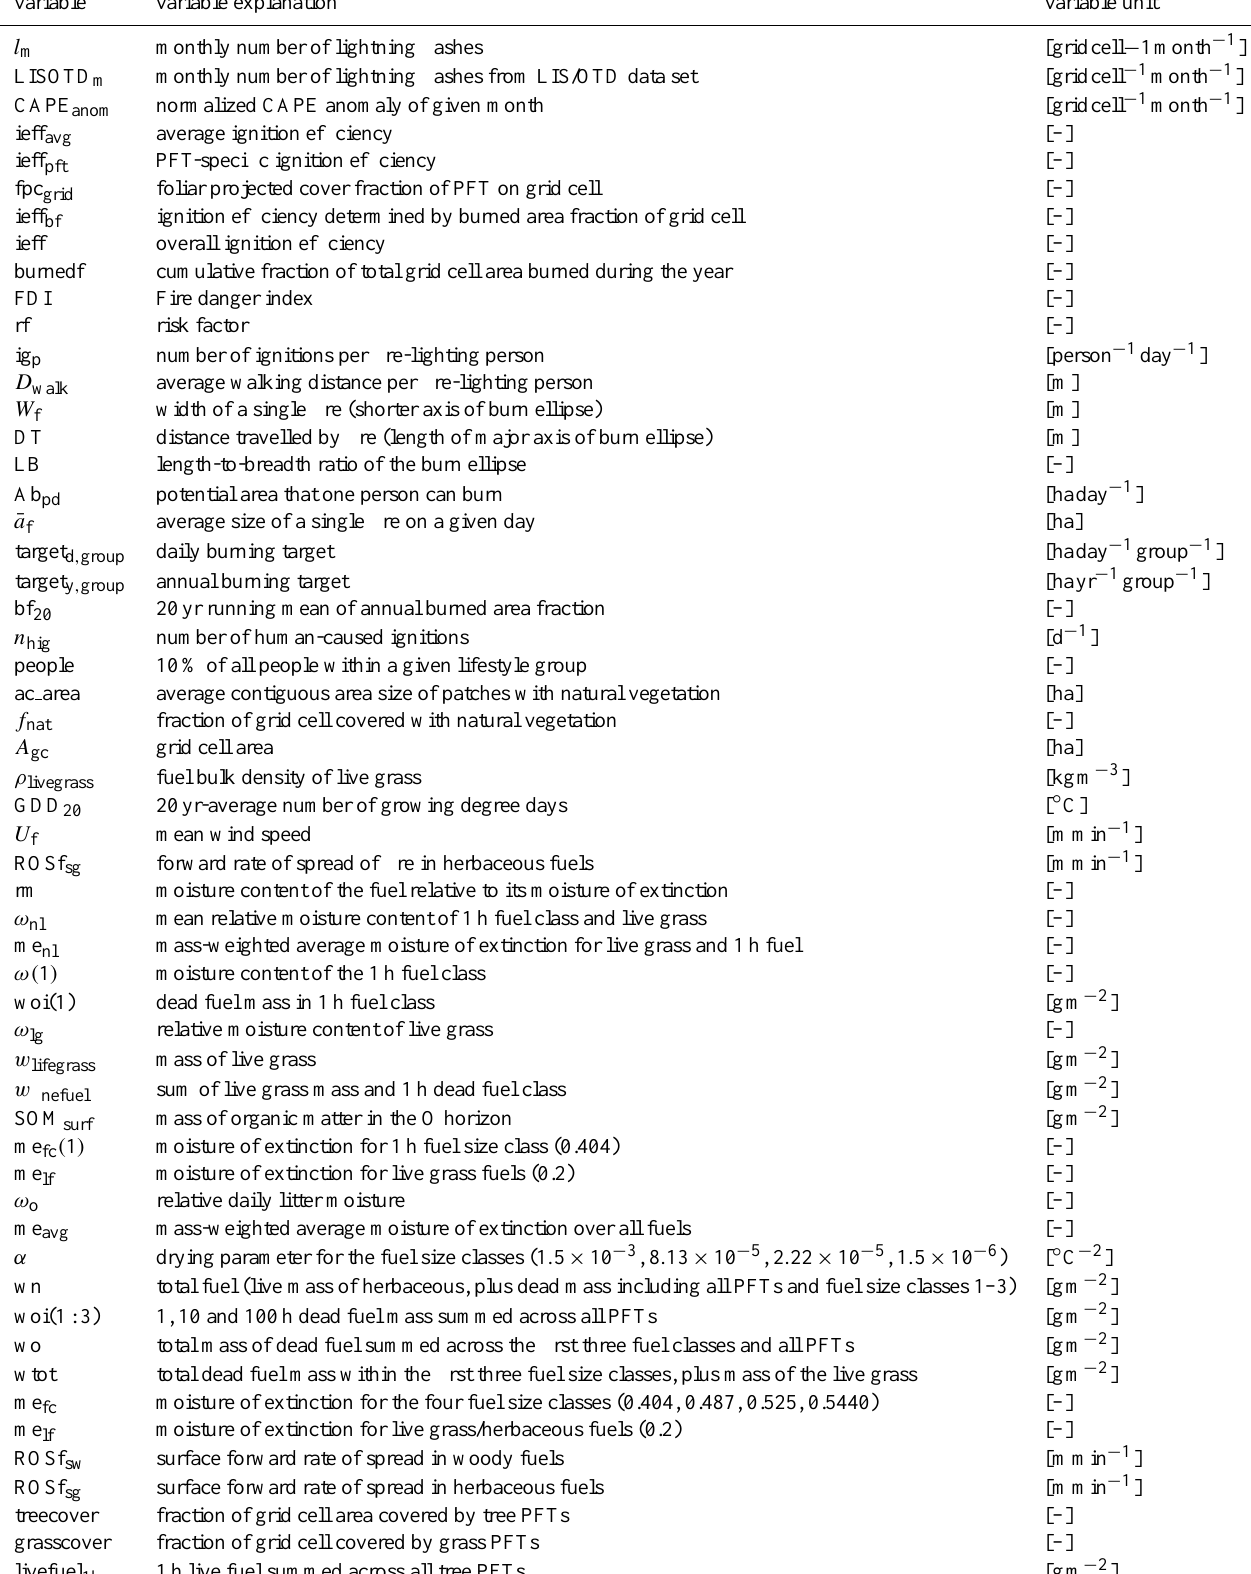
Table 1. Explanation of variable and parameter abbreviations. variable variable explanation l